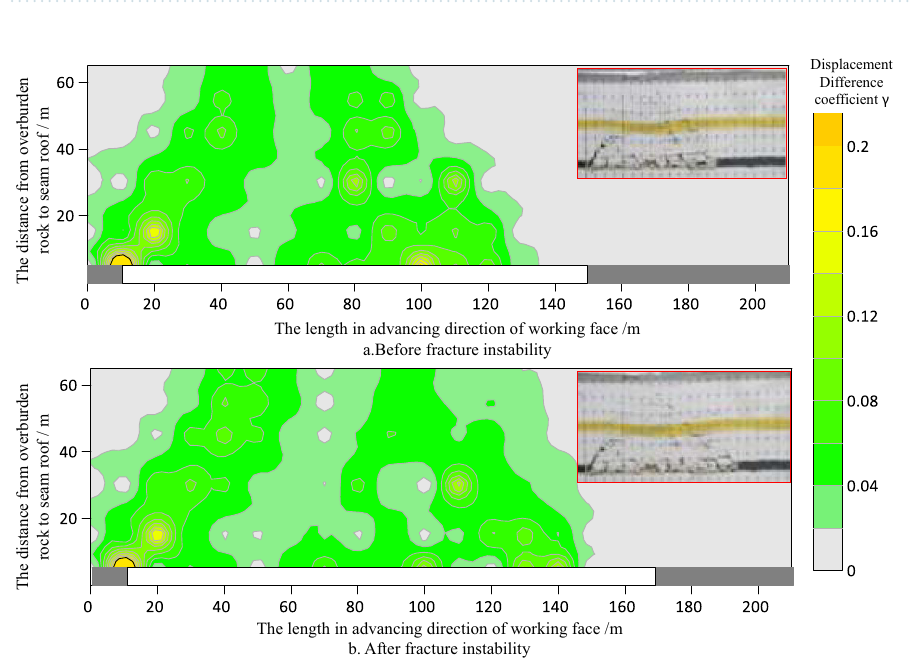
Figure 9. Contours of displacement difference coefficient γ before and after key bearing layer movement in shallow thick seam mining (key bearing layer in fractured